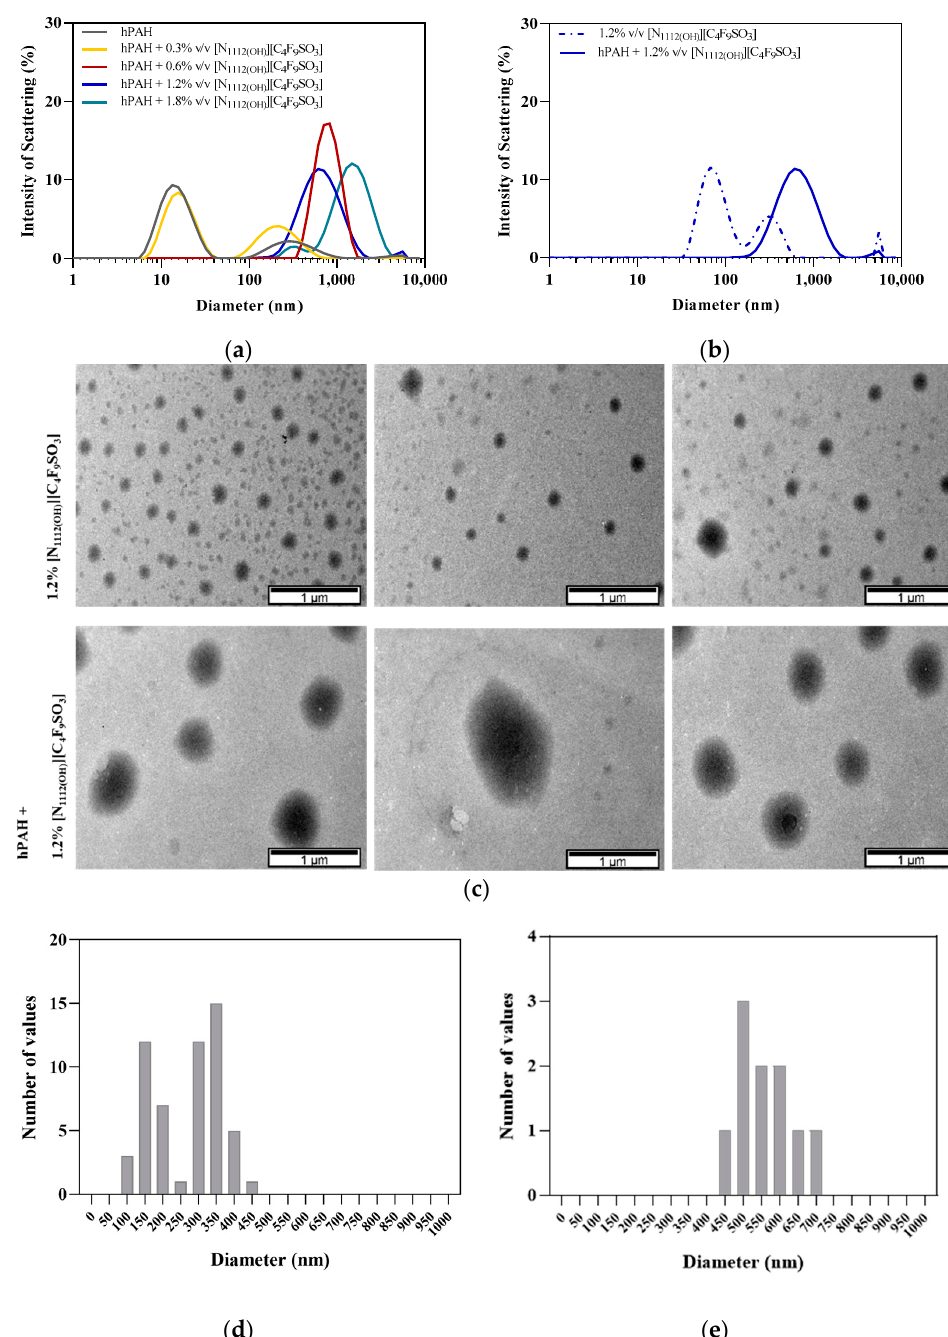
Figure 8. Encapsulation of hPAH by [N 1112(OH) ][C 4 F 9 SO 3 ]. DLS spectra of hPAH upon: ( a ) the addition of increasing concentrations of FIL; and ( b ) comparison between 1.2% v/v FIL Blank with hPAH + 1.2% v/v FIL. ( c ) TEM analysis of 1.2% v/v FIL (top) and hPAH + 1.2% v/v FIL (bottom). Size distribution (Feret diameter) of particles present in TEM images: ( d ) 1.2% v/v FIL and ( e ) hPAH + 1.2% FIL v / v , quantified using ImageJ